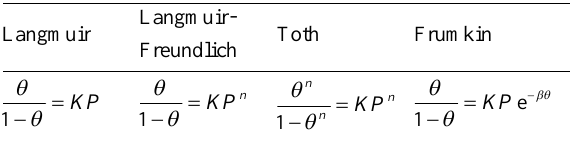
Table 1. Some of the important isotherm models which have been used in the present work